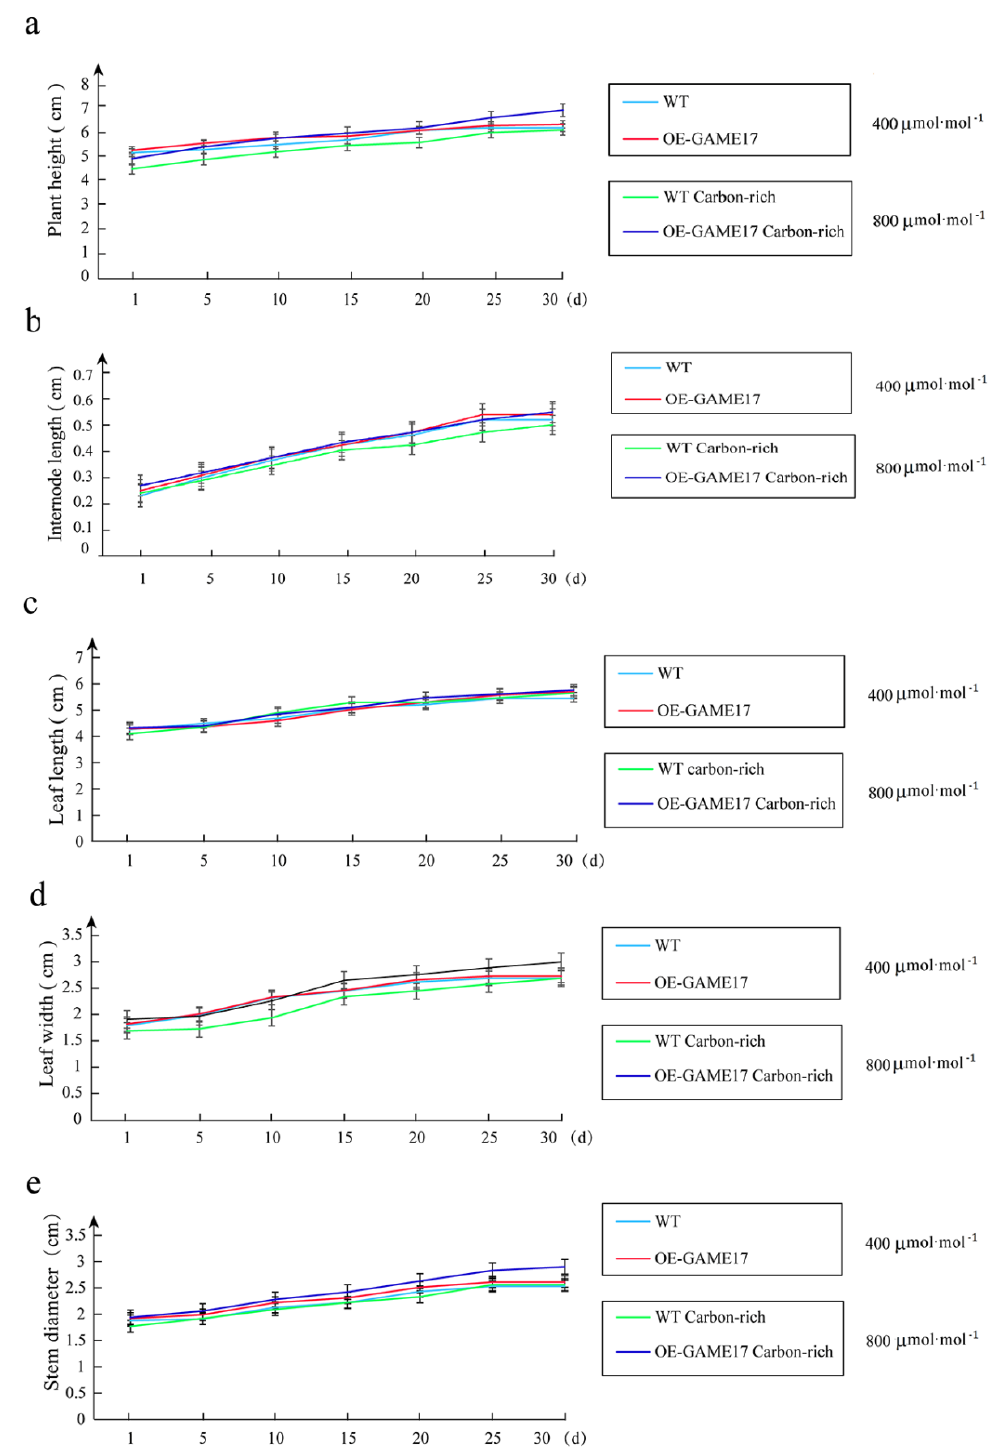
Figure 7. Comparison of the growth parameters between transgenic tomato plants. ( a ) The average plant height in transgenic tomato plants; ( b ) the average internode length in transgenic tomato plants; ( c ) the average leaf length in transgenic tomato plants; ( d ) the average leaf width in transgenic tomato plants; ( e ) the average stem diameter in transgenic tomato plants.